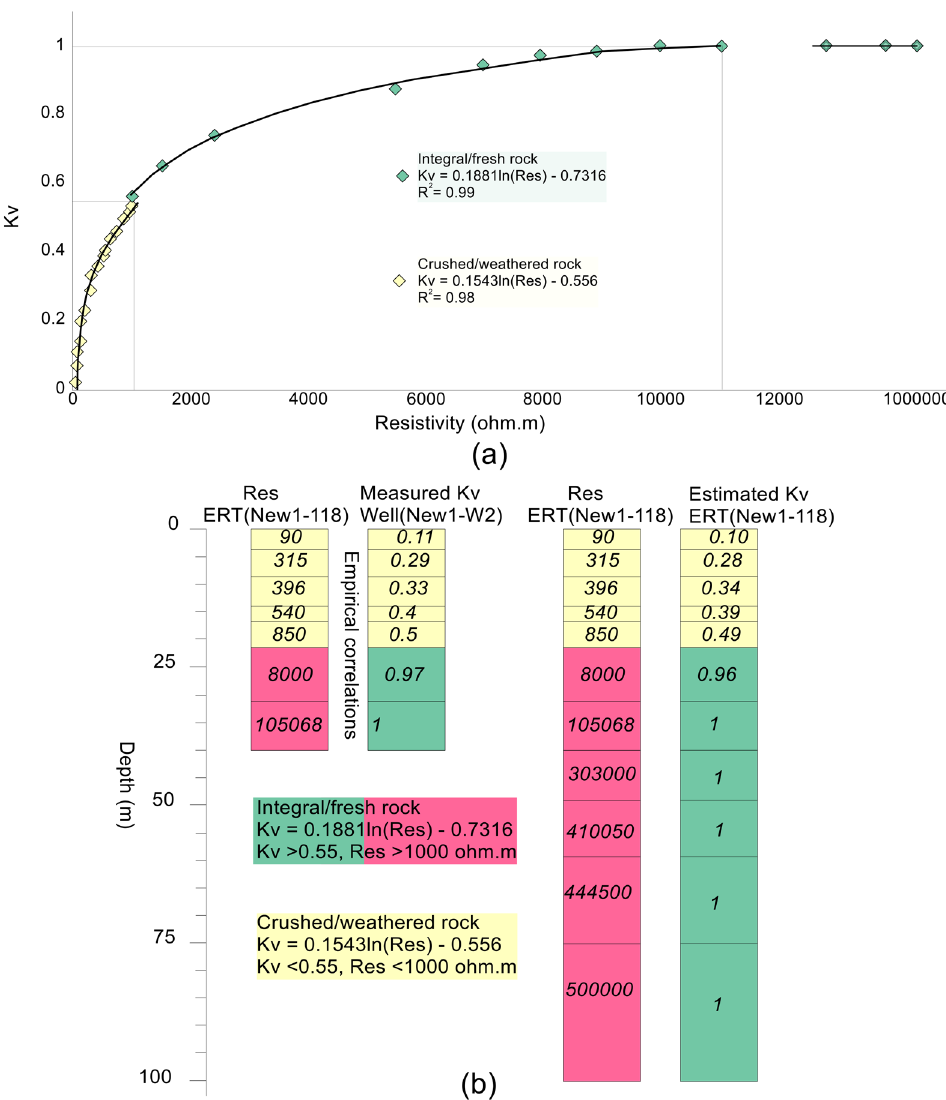
Figure 3. ( a ) Empirical correlations between the inverted electrical resistivity acquired from the selected ERT data points and the rock mass integrity coefficient (Kv) measured from the limited drilling test data. ( b ) An example of the correlation process between the selected ERT point NEW1-118 and Kv of borehole well 2.